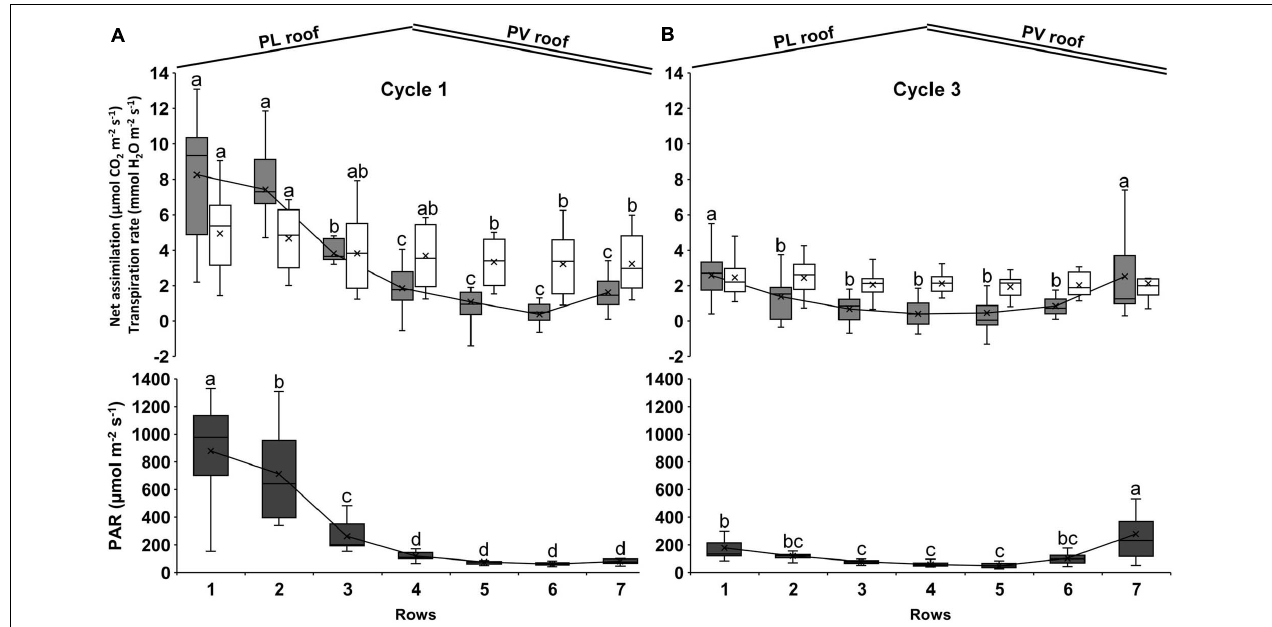
FIGURE 7 | Average net photosynthetic assimilation rate (gray bars), transpiration rate (white bars) and PAR radiation (black bars) during cycle 1 (A) and cycle 3 (B) . The measurements were performed on one plant per row from 10:00 to 12:00 and comprise 4 days during cycle 1 (April 29, May 7, May 27, and June 4, 2013) and 3 days on cycle 3 (September 29, October 10, and October 24, 2013). Each bar represents the data distribution on the row: the upper and lower parts are the first and last quartile, respectively, the internal line is the median, and the cross is the mean. The upper and lower error bars are the maximum and minimum values, respectively. Each bar includes the four corresponding rows of each experimental area. Bars that do not share a letter are significantly different (LSD test p <